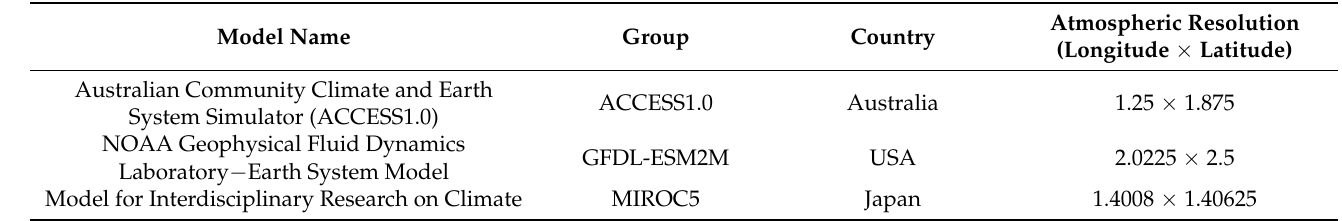
Table 2. Description of the climate models applied in the study for future climate variable projection under RCP 4.5 and RCP